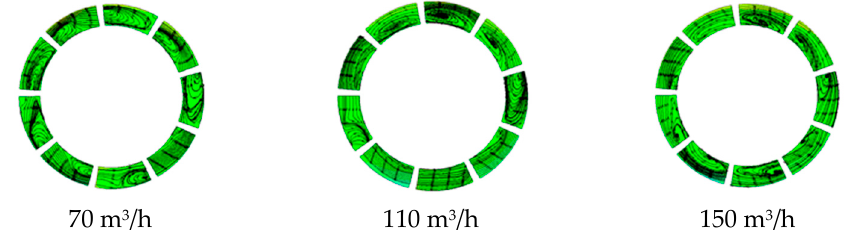
Figure 15. The streamline distribution of the middle section of the inlet section of the first static impeller. Figure 16. The streamline distribution of the middle section of the middle section of the first static impeller.